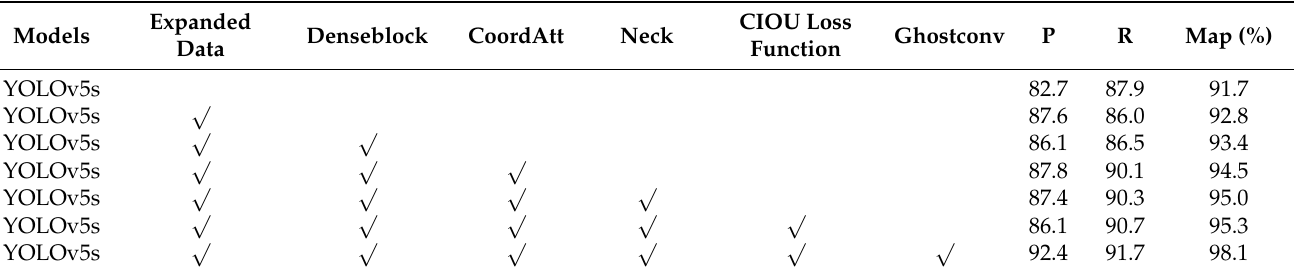
Table 3. Results of ablation experiments.